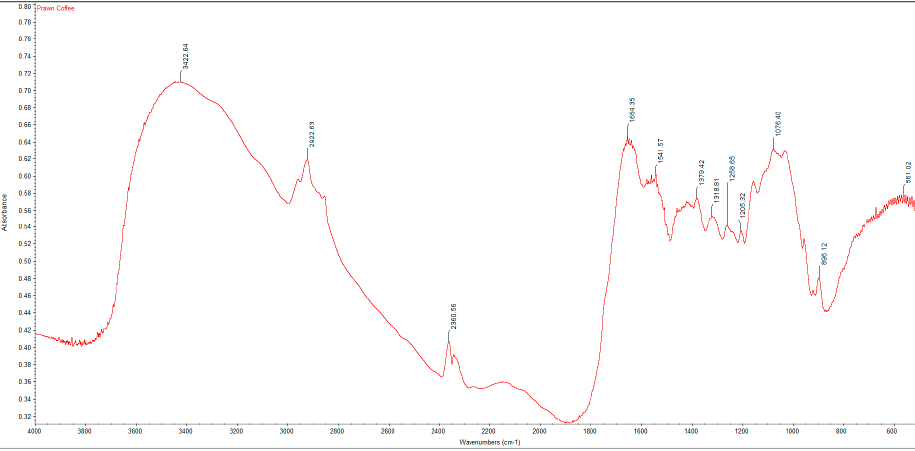
Figure 2. FTIR spectra of crustacean chitin extracted after fermentation on coffee waste.